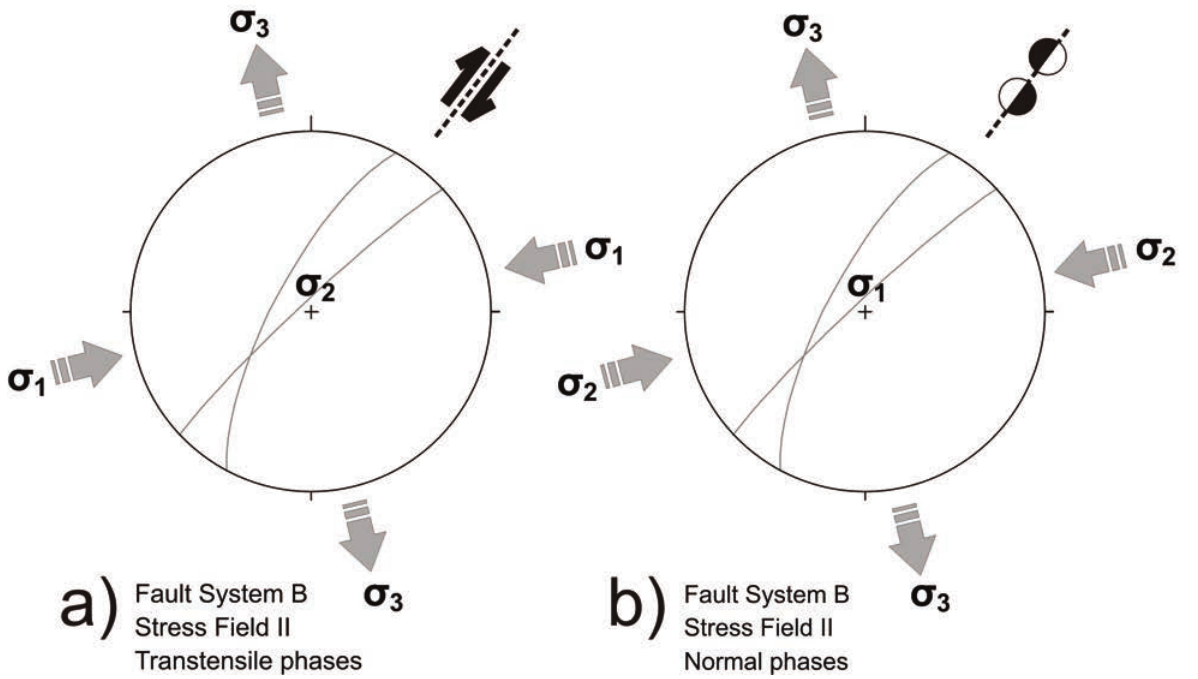
Figure 15. Stereographic projection of the stress field #2 deduced from structures of fault system B that have kinematic data of both slip components (lower hemisphere of Schmidt net – β diagram). a) transtensile stress field: NNE-SSW to NE-SW faults with dominant dextral slip component. Horizontal ENE-WSW σ 1, horizontal NNW-SSE σ 3 and vertical σ 2; b) tensile stress field after permutation between σ 1 and σ 2: NNE-SSW to NE-SW faults, dipping to both sides, with dominant normal slip component. Vertical σ 1, horizontal NNW-SSE σ 3 and hor- izontal ENE-WSW σ 2. TectonicsFP software® [Ortner et al.